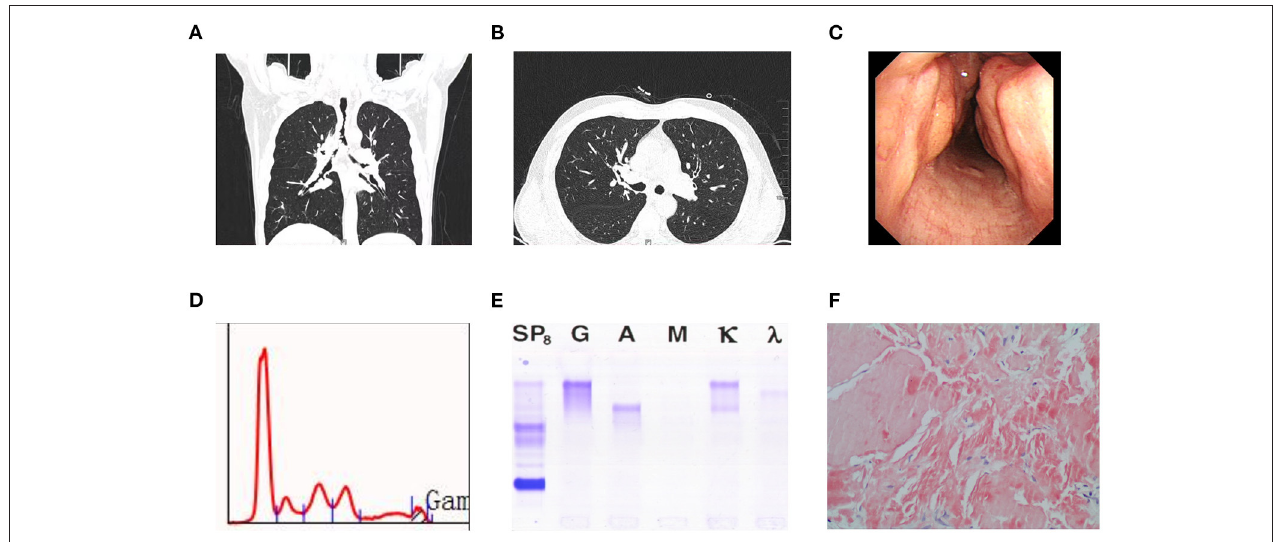
FIGURE 1 | (A) Computed tomography scan revealed uneven thickening of the walls of the trachea and bronchi at different levels with luminal narrowing. (B) Computed tomography scan showed obliteration in the right intermediate bronchus, but pulmonary parenchyma were normal. (C) Bronchoscopy revealed roughness of mucosa in trachea and multiple nodular in airway lumen. (D) Serum protein electrophoresis showing an M-peak in the gamma fraction. (E) Serum immunofixation electrophoresis. It shows biclonal gammopathy of IgG kappa type and IgA kappa type. (F) Amyloidosis was confifirmed by tissue biopsy, which showed Congo red dye staining of lesion was positive (Hematoxylin and Eosin, × 200).